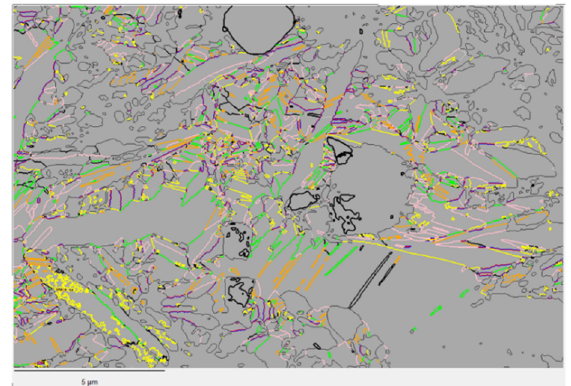
Figure A1. TKD map of a fully martensitic B19 ′ NiTi alloy with the junction boundaries colored as function of the operators, such as in Figure 5.